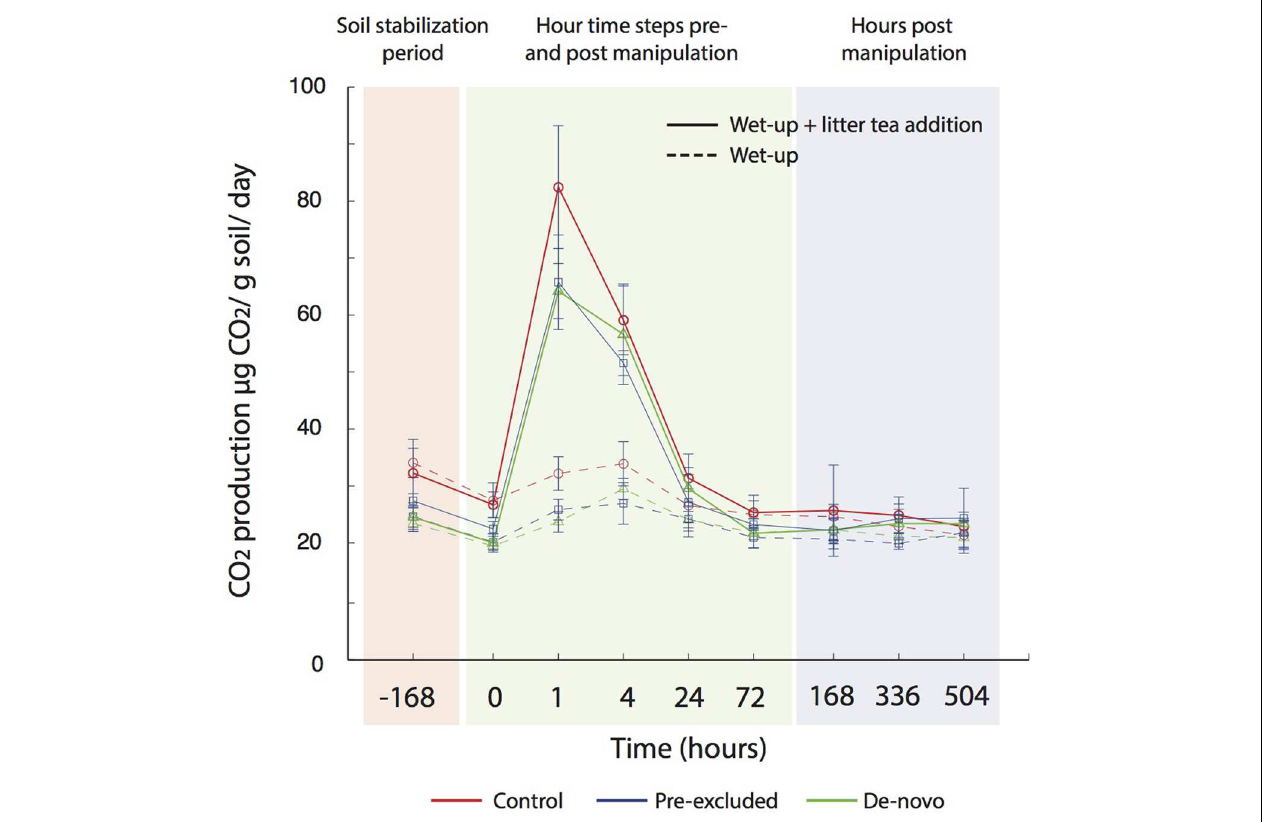
FIGURE 5 | Measured CO 2 flux following wet up with and without additional substrate (leachate) addition. A period of stabilization followed transfer of soils to mason jars ( − 168 h), prior to the addition water ( ± leachate), after which measurements were made in relatively high frequency over the first 3 days, and then measured once a day for 3